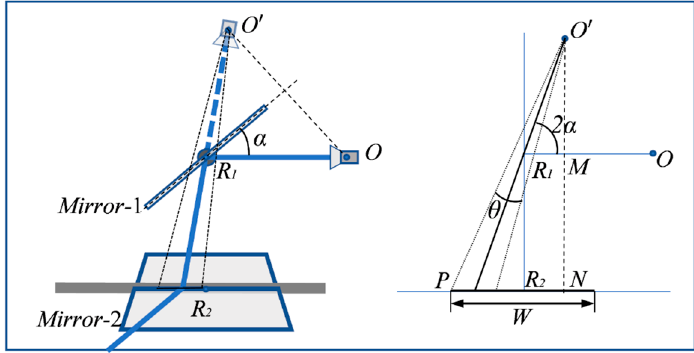
Figure 3. Camera imaging through galvanometer scanner.